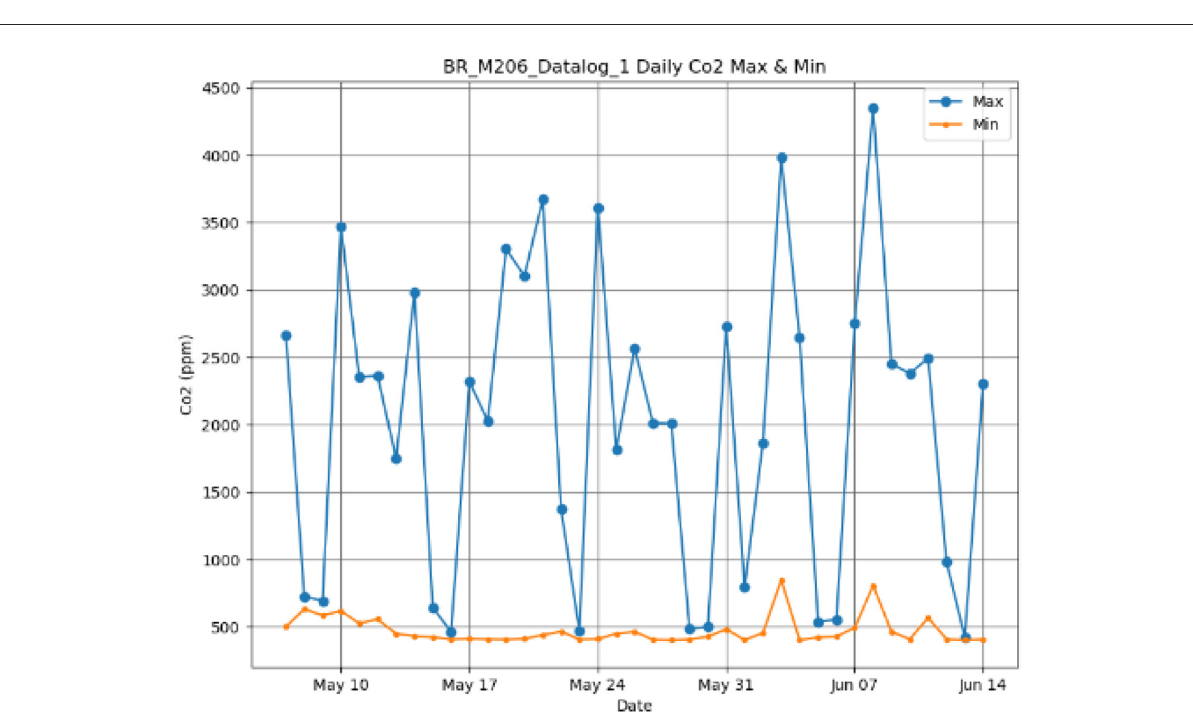
FIGURE9 Maximum and minimum CO 2 values observed in Classroom A-throughout the whole deployment period of 8th May 2021 to 14th June 2021. Timestamps are approximate